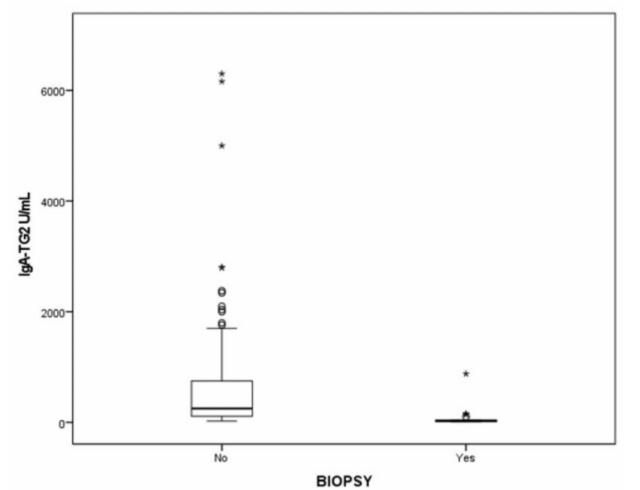
Figure 4. Values of IgA-TG2 (U/mL) in patients who avoided biopsy or underwent it. Abbreviations: IgA-TG2, antibodies against tissue transglutaminase Type 2. ◦ , Outliers are values between IORs and three IORs from the end of a box. * Values more than three IORs from the end of a